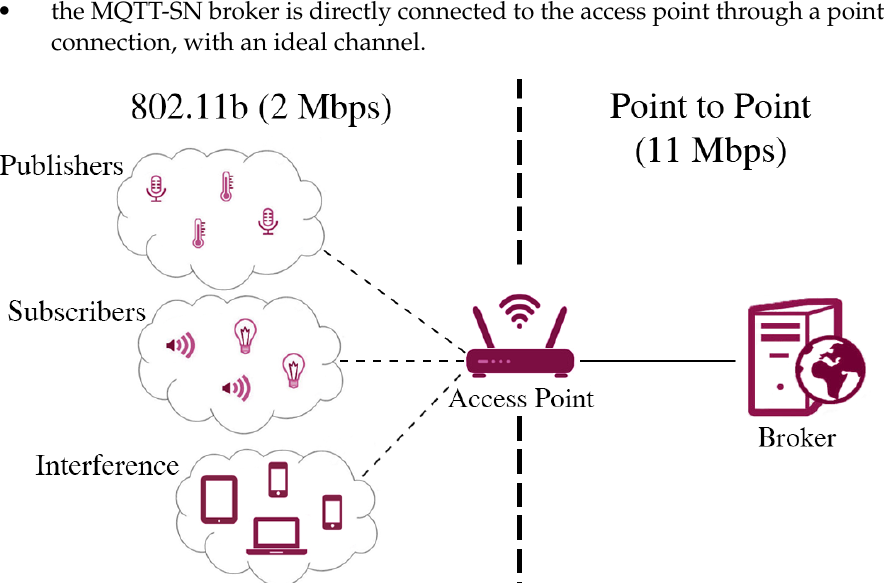
Figure 2. Simulator